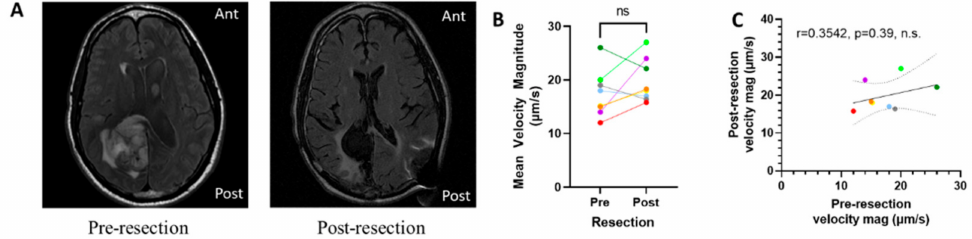
Figure 4. Interstitial fluid velocity is apparent after tumor resection. ( A ) Representative images from a pre- (left) and post- (right) resection tumor (Patient W-33). ( B ) Change in mean velocity magnitude by patient pre- and post-resection. ( C ) Correlation of pre-resection velocity with post-resection velocity magnitude. Correlations are shown with 95% CI, and colors indicate different patients and are consistent with Figures 2 and 3, ns = not significant, CI = confidence